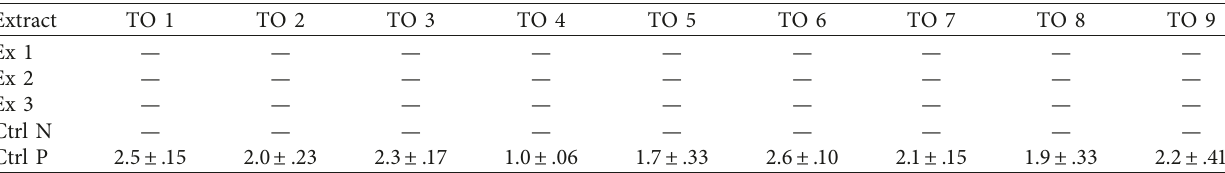
Table 6: Antimicrobial activity of fractions of unripe fruits against test